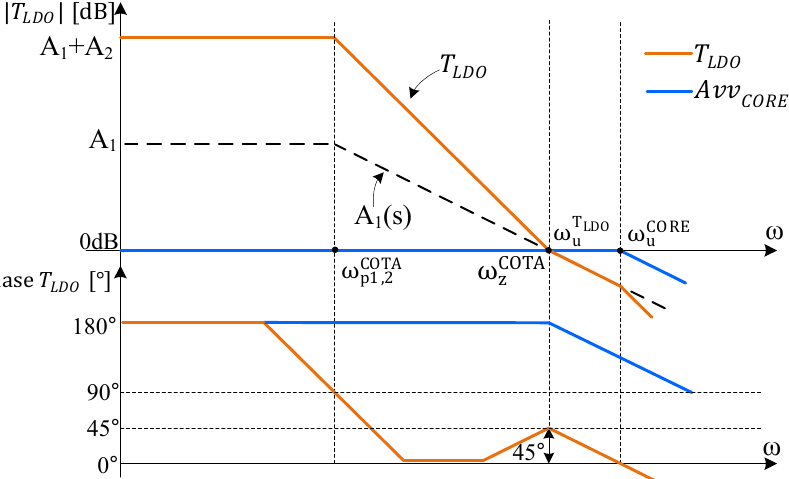
Figure 5. Module ( top ) and phase ( bottom ) frequency characteristics of the T LDO described by (12). T LDO represents an inverting gain; therefore, its phase characteristics start from 180 ◦